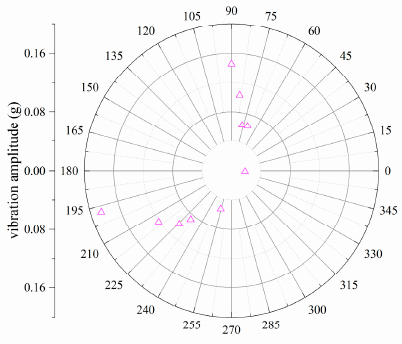
Figure 22. Vertical polar diagram of pitch.